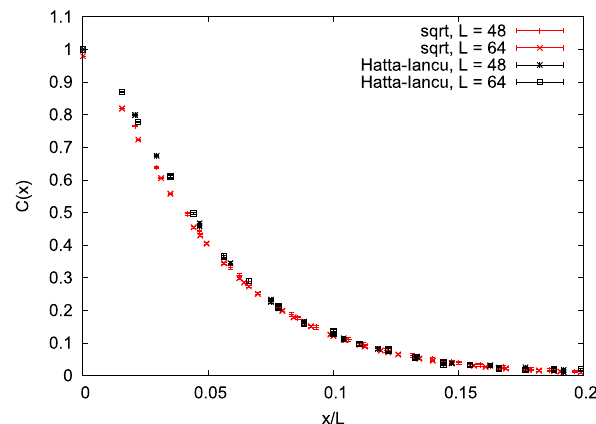
Fig. 17 Comparison of correlation functions at s = 0 . 05 in position space calculated using the “square root” and Hatta–Iancu prescriptions. Statistically significant deviations can be observed for small separa- tions. Results for two volumes, L / a = 48 and L / a = 64 are shown, pointing to the conclusion that the differences cannot be attributed to finite volume effects but to the intrinsically different physical effect